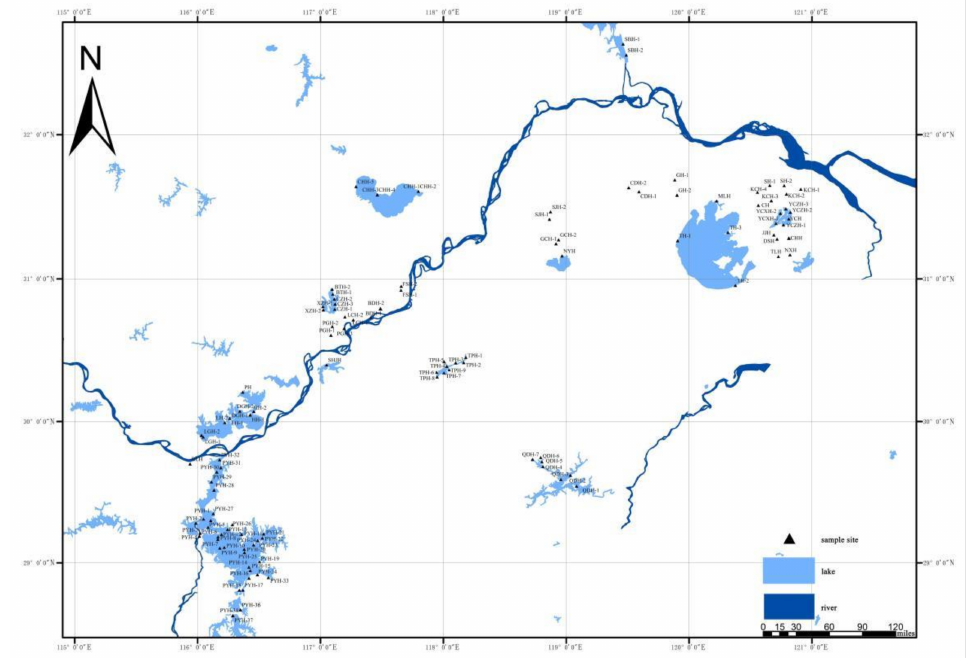
Figure 1. Sample sites in the lakes in the lower reaches of the Yangtze